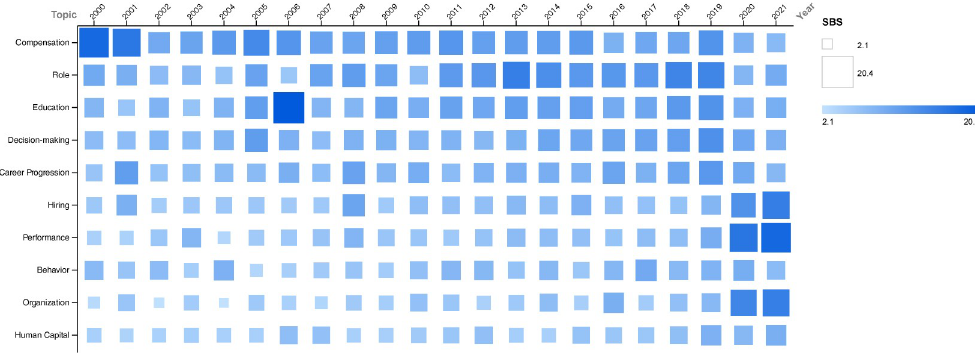
Fig 2. SBS time series of the top 10